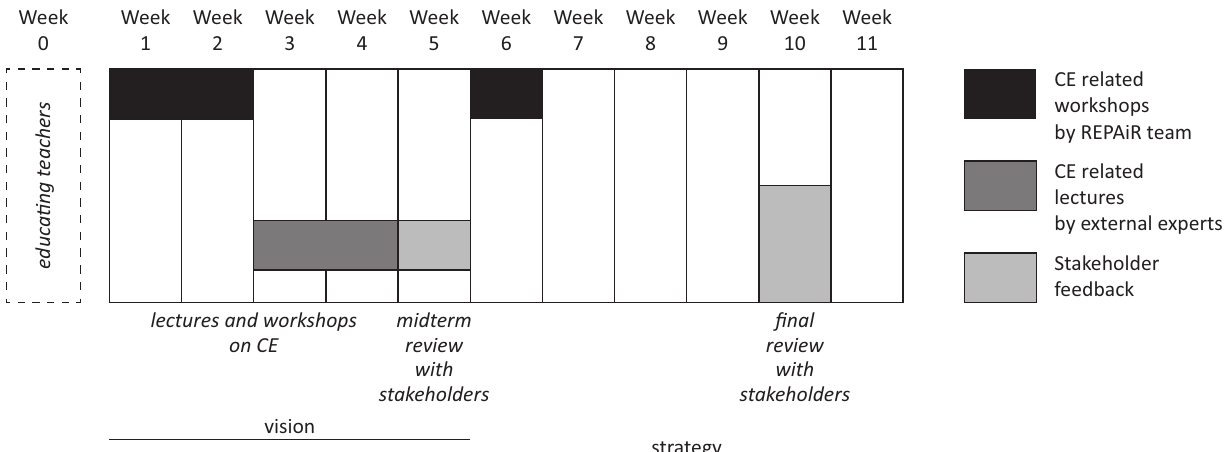
Figure 1. The simplified timeline of the Spatial Strategies for the Global Metropolis course illustrating the CE related input and stakeholder